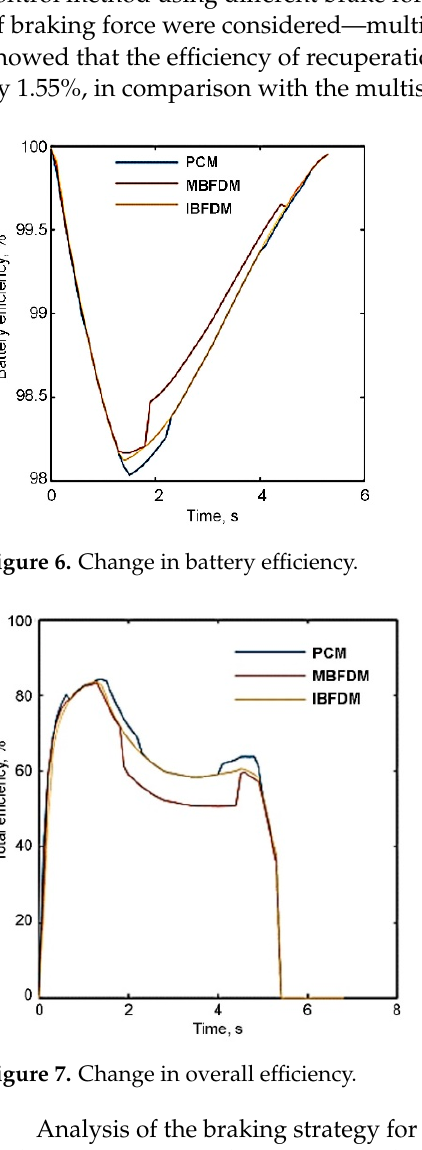
Figure 8. Comparison of energy consumption. The multicriteria optimization system proposed in [38], as well as the method for optimizing the parameters of the regenerative braking control strategy (SRCS), consists of several steps: 1. RRBCS balancing braking efficiency (BP), regenerative braking loss efficiency (RBLE), and battery capacity loss ratio (BCLR). They were proposed and used in the simulation. 2.